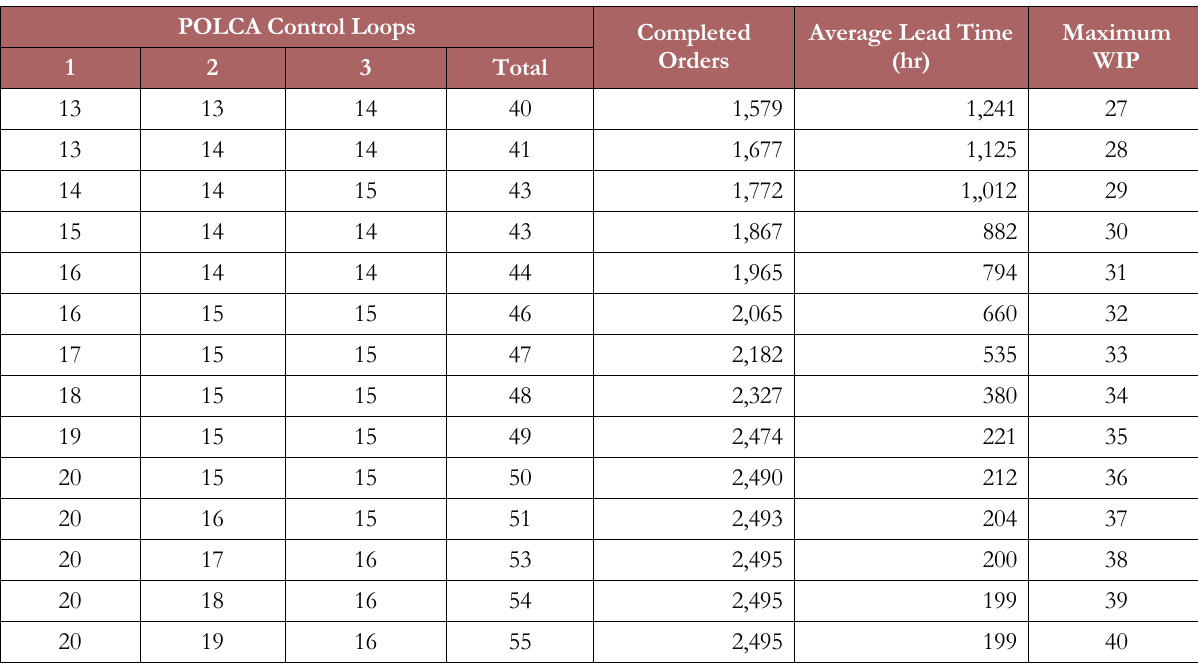
Table 9. POLCA Parameter Control Simulation Results – Constant